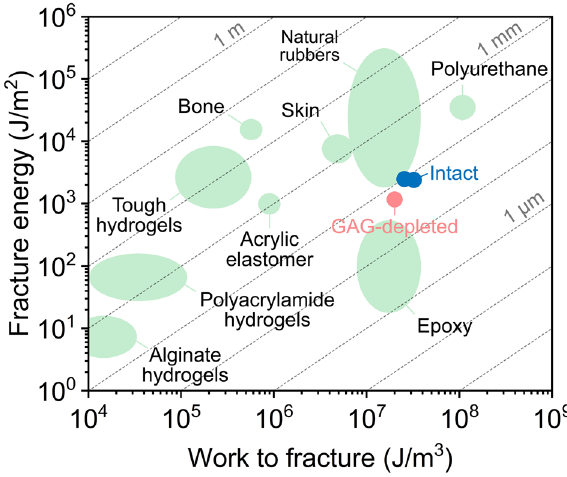
Figure 5. Comparison of intact and GAG-depleted cartilage with other materials in terms of the fracture energy, work to fracture, and length of flaw sensitivity. The diagonal lines represent the length of flaw sensitivity, calculated by dividing fracture energy (critical energy release rates) by work to fracture. The mechanical properties of other materials were from previous studies 53,65–69 . The conversion of the mechanical properties into this plot was explained in a previous study 53 . The data points of intact and GAG-depleted cartilage were obtained from a pre-relaxation timescale, and the detailed process was included in the supplementary text, Fig. S3 and Fig.